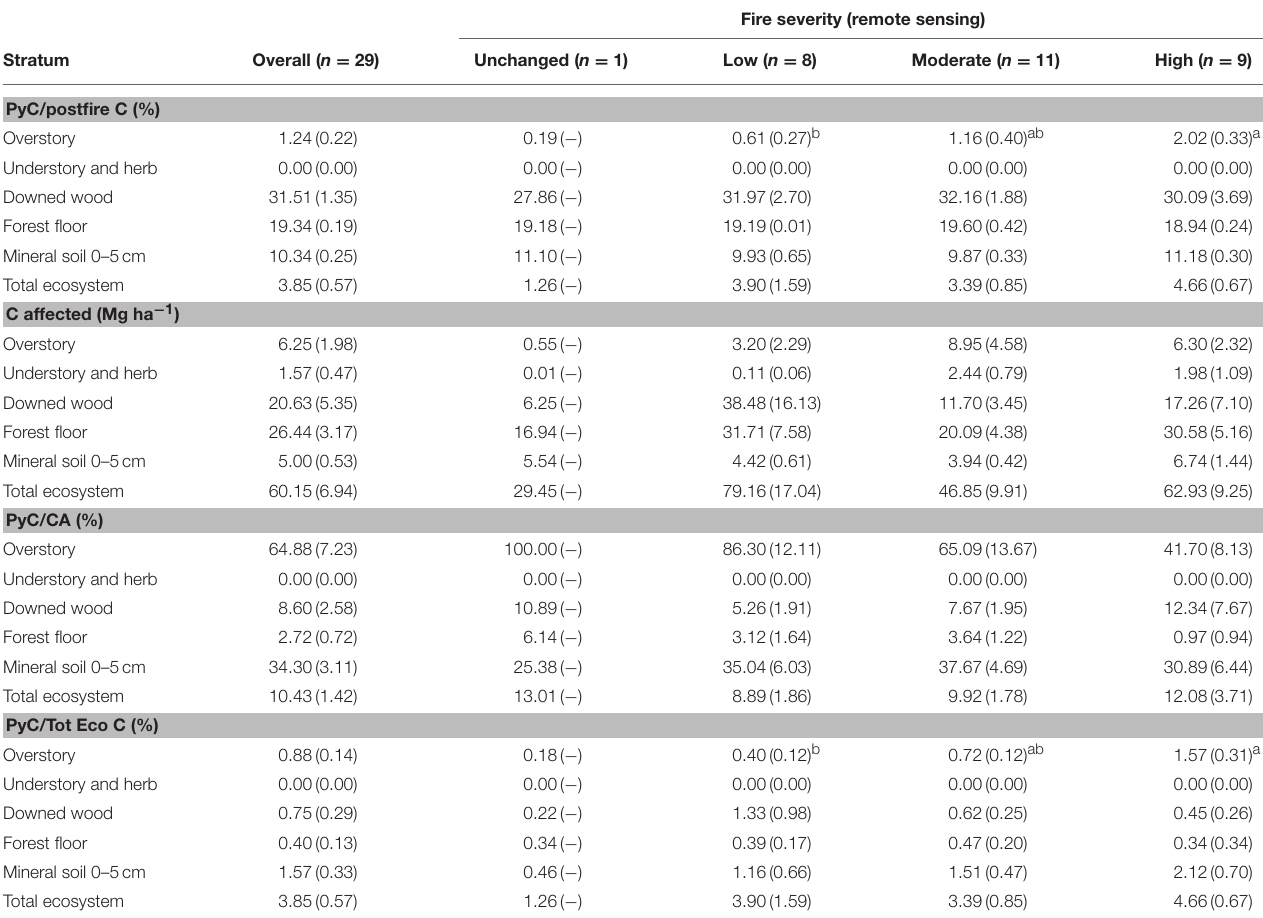
TABLE 3 | Post-fire PyC (estimated as PyC CTR via chemical oxidation) proportions of post-fire C, C affected, and post-fire total ecosystem C for plots measured before and after fire in mixed-conifer forest type.